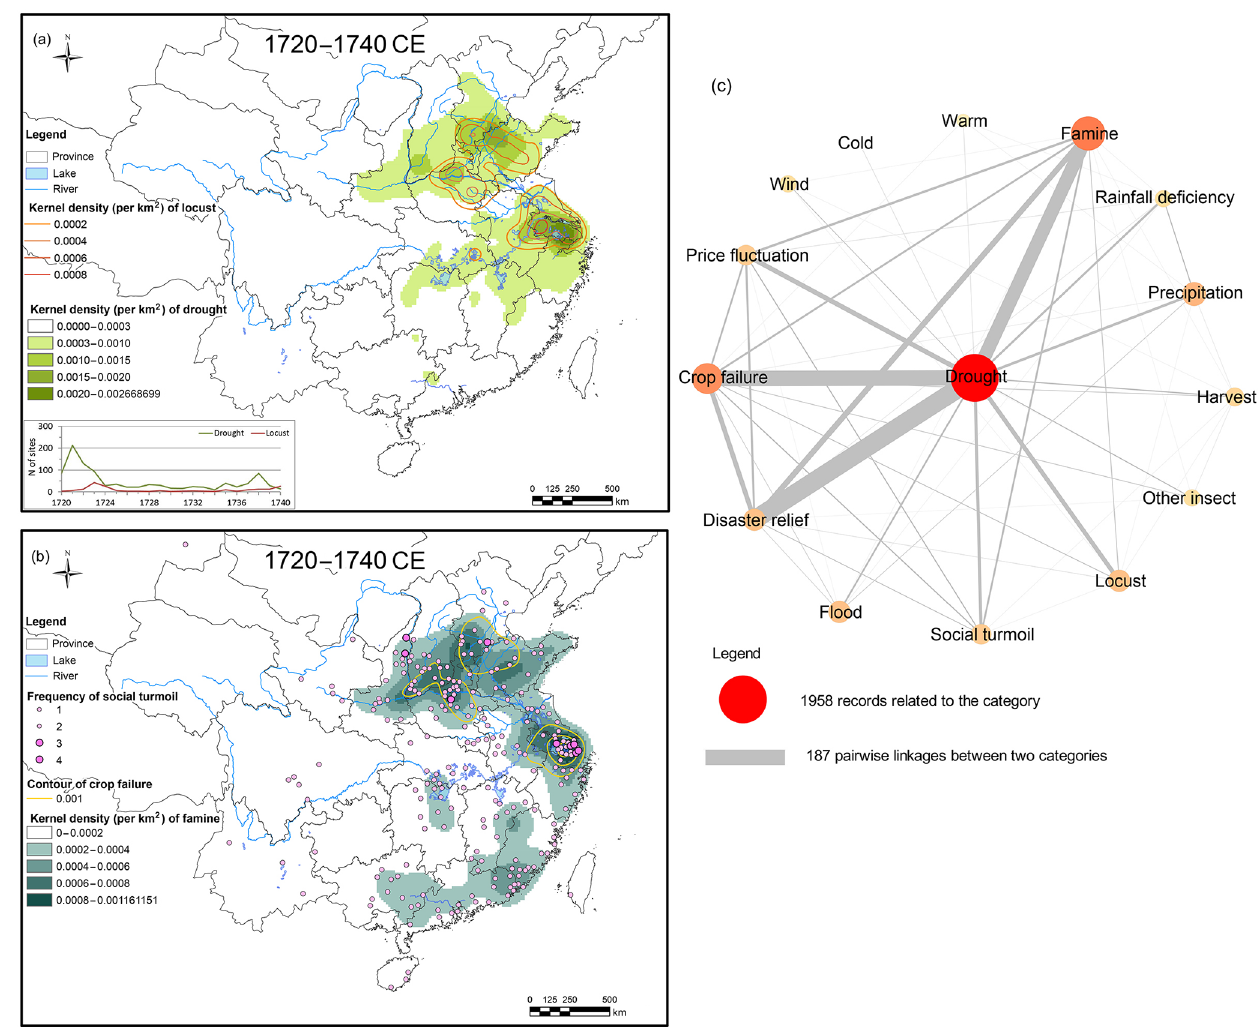
Figure 8. Spatial distribution of the kernel density function of drought and locust outbreaks (a) and social turmoil (b) , and the social network chart (c) in the drought period